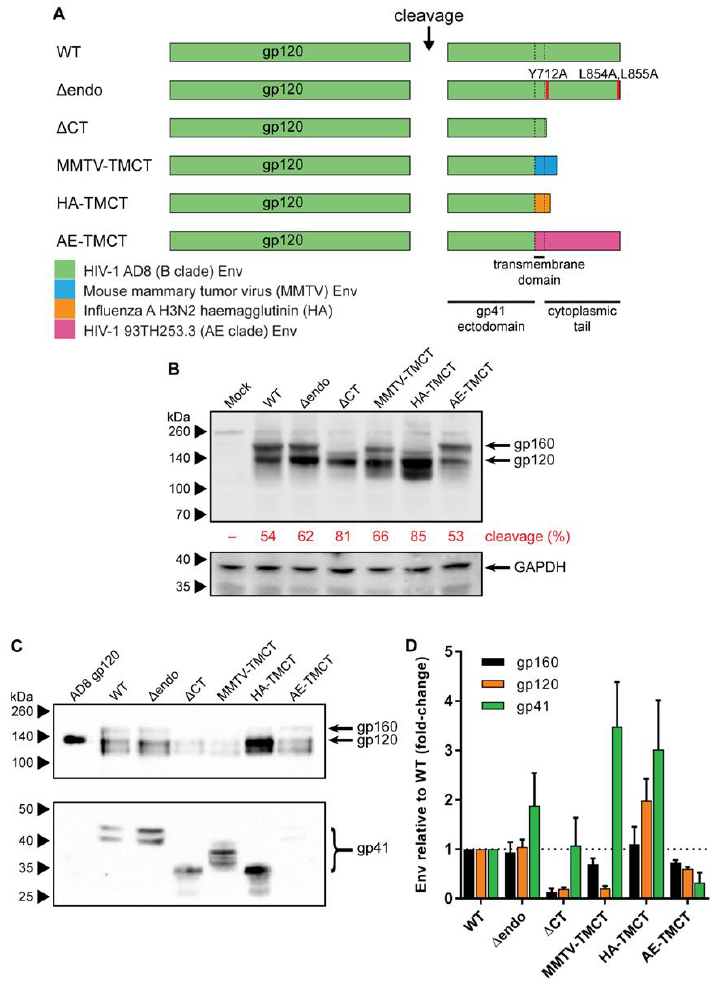
Figure 1. Genetic organization, expression, and VLP incorporation of Env with TM and CT domain modifications. ( A ) Schematic representation of TM- and CT-domain-modified AD8 gp160 sequences compared to the wild-type (WT) sequence. Env CT motifs associated with endocytosis were removed (Δendo) by introducing Y712A, L854A, and L855A amino-acid substitutions (red shading). The CT was completely removed (ΔCT) by truncating Env immediately C-terminal of the TM. The HIV-1 AD8 TM and CT were replaced with the equivalent TM and CT sequences from mouse mammary tumor virus (MMTV-TMCT), influenza A (IFA) subtype H3N2 haemagglutinin (HA-TMCT), or HIV-1 93TH253.3 strain (AE clade) Env (AE-TMCT). Dashed lines indicate boundaries between gp41 ectodomain, TM, and CT. Shading represents source of TM/CT sequence in mutants according to key in lower left. ( B ) Representative anti-gp120 (upper panel, probed with D7324) and anti-GAPDH (lower panel, probed with 14C10) Western blot of 293T cell lysate following transfection with an empty vector (Mock) or vectors expressing the gp160 sequences described in ( A ). The percent of cleaved Env (gp120) relative to gp160 expression was calculated for Env sequence by densitometric analysis. ( C ) Representative anti-gp120 (D7324) and anti-gp41 (2F5) Western blot of Env-deficient mVLPs (mVLPΔenv) pseudotyped with wild-type AD8 gp160 (WT) and various TM- and CT-modified gp160 as described in ( A ). The 200ng recombinant AD8 gp120 is shown as reference. VLP sample loading was equalized by p24 ELISA. For ( B , C ), proteins were resolved by 8–16% SDS-PAGE under reducing conditions. Protein sizes were indicated by the Spectra Multicolor Broad Range Protein Ladder (Thermo Fisher Scientific) and shown on the left. The position of gp160, gp120, and gp41 bands are indicated. ( D ) Western blot densitometric analysis on TM- and CT-modified Env gp160, gp120, and gp41 incorporation into mVLPs as fold-change relative to mVLPs pseudotyped with WT gp160. Values shown are the mean and SEM of 3 independent experiments.